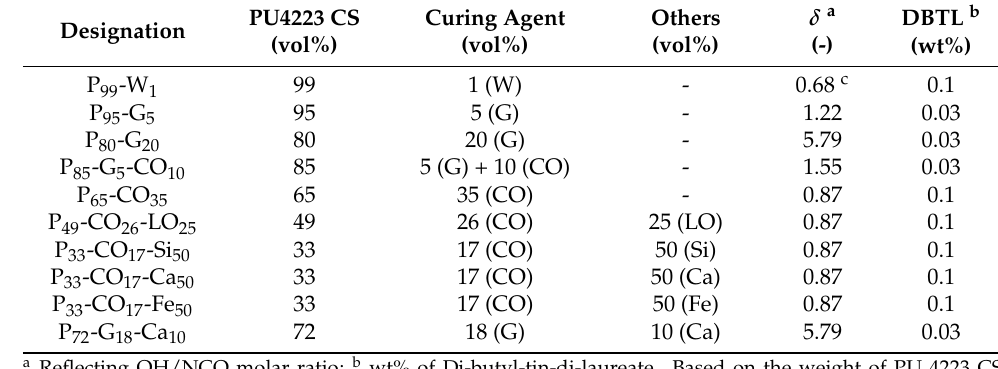
Table 1. Chemical composition of PUR matrices (P—PU4223 CS; curing agents: W—water, G— glycerol, CO—castor oil; plasticizer: LO—linseed oil; fillers included in matrices: Si—SiO 2 , Ca— CaCO 3 , Fe—Fe). Table taken from previous work [33] *. PU4223 CS